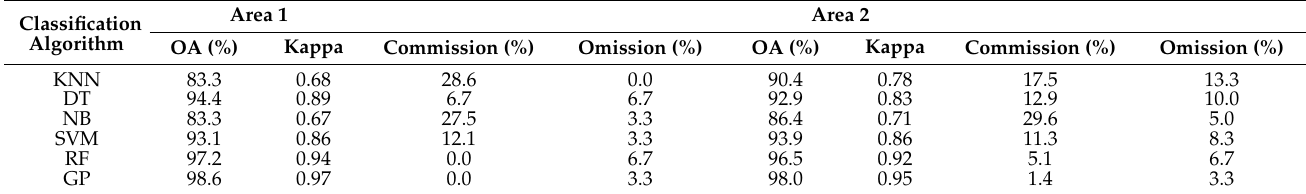
Table 3. Classification results of different classifiers in Area 1 and Area 2.